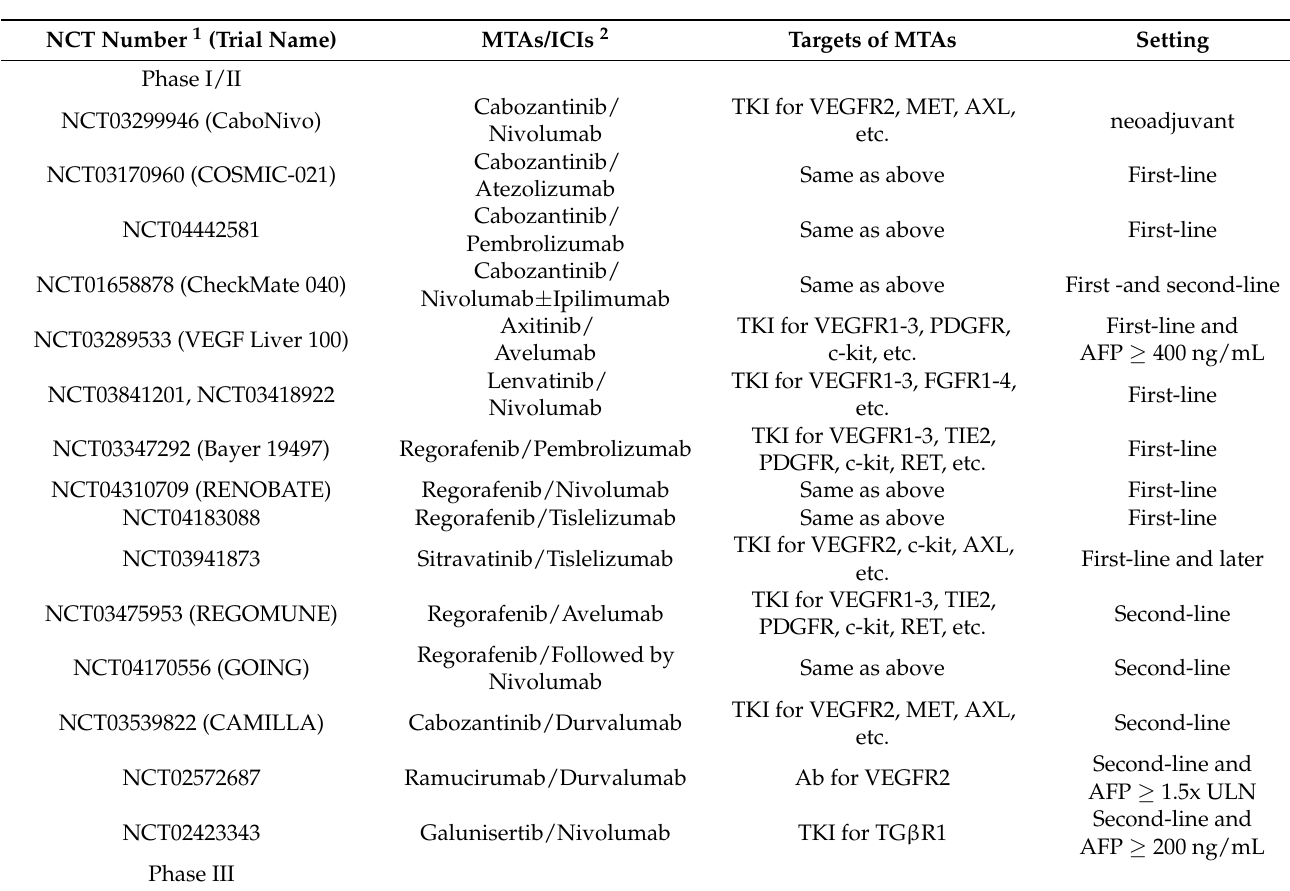
Table 1. Clinical trials for combinations of molecular targeted agents and immune checkpoint inhibitors in hepatocellu- lar carcinoma. NCT Number 1 (Trial